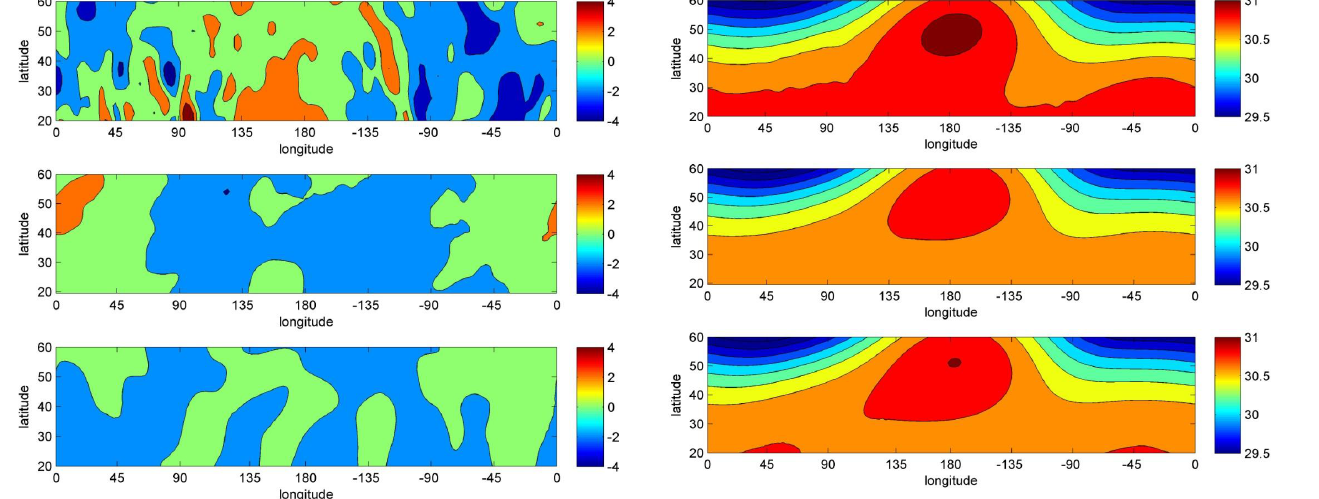
Figure 3. The same as Fig. 1 but for July. Positive values (poleward wind): red; negative values (equatorward wind): blue.